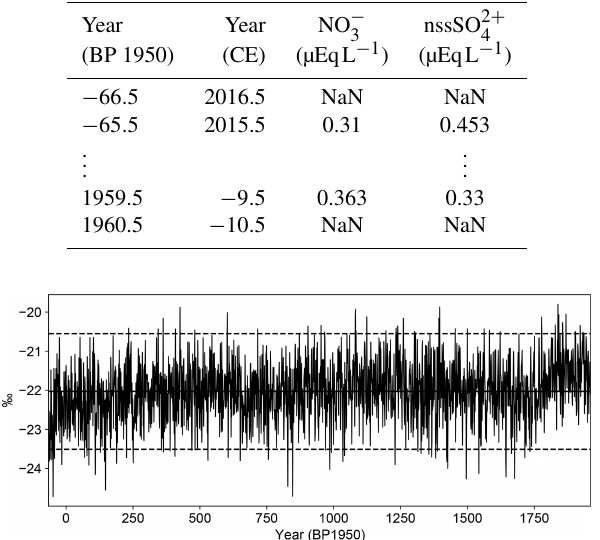
Figure 7. Time series for annually averaged δ 18 O. Solid black line indicates the 2000-year mean value. Dashed black lines indicate ± 2 σ values.